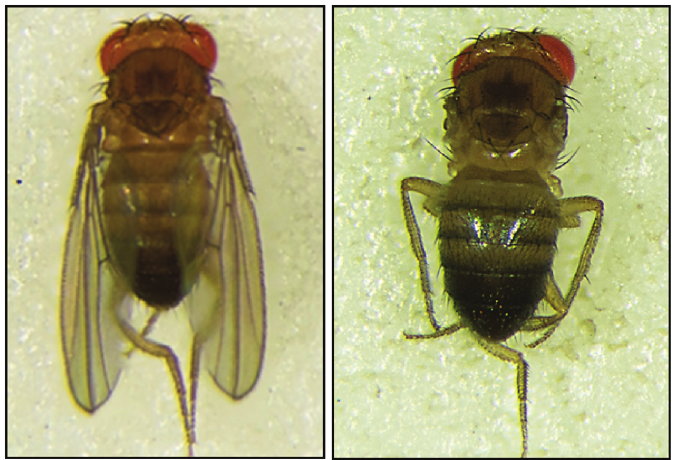
Figure 5. Knockdown of Dis3 in D. melanogaster wing imaginal disc results in a severe “no wing” developmental phenotype (right) compared to wild-type (left)